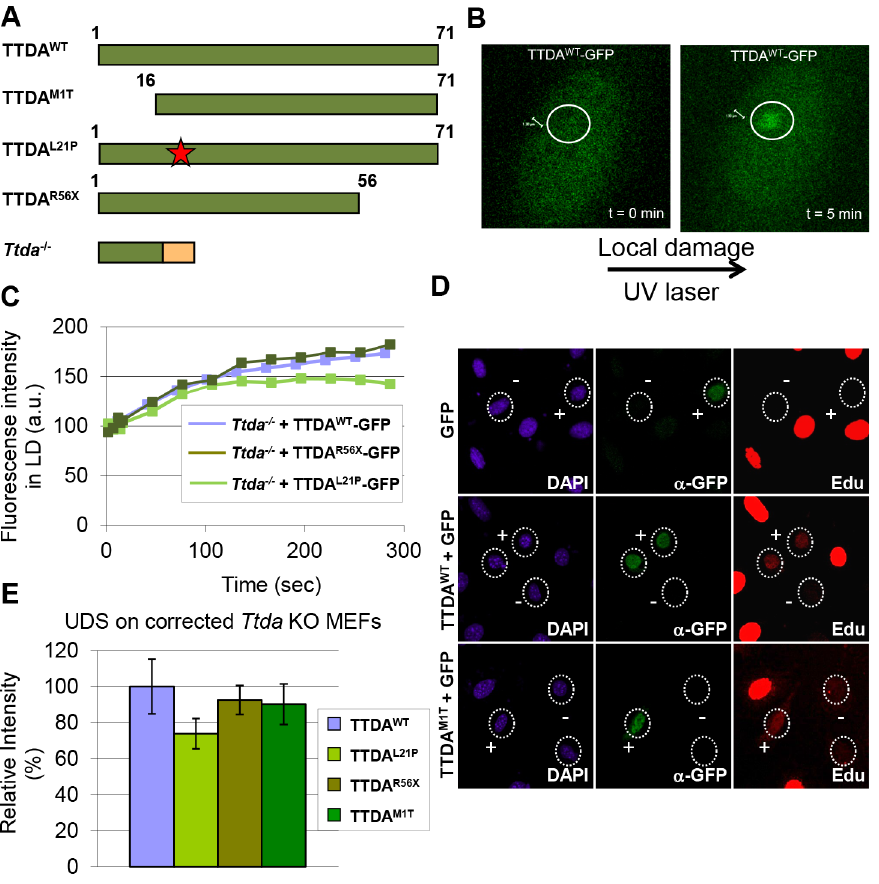
Figure 5. Mutant TTDA protein accumulation at local UV damage. (A) Schematically representation of the predicted TTDA polypeptide length (in amino acids) in human wild-type cells (TTDA WT ), TTD-A patient cells (TTDA M1T , TTDA L21P and TTDA R56X ) and the Ttda knock-out cells ( Ttda 2 / 2 ). The red star represents the mutation found in TTDA L21P and the red part of the Ttda 2 / 2 bar represents intronic encoded non-sense amino acids. (B) Representative confocal images of Ttda 2 / 2 MEFs expressing TTDA WT -GFP before (t=0 min) and after local UV-damage infliction (t=5 min) in a selected area inside the nucleus (dashed circle). (C) Accumulation kinetics of TTDA WT -GFP, TTDA L21P -GFP and TTDA R56X -GFP to local UV-C (laser- induced) DNA damage expressed in Ttda 2 / 2 MEFs. Graphs represents the mean GFP-derived fluorescence intensity at the damaged spot at the indicated time points from approximately 12 cells. (D) Representative confocal microscope images of UV-induced UDS of Ttda 2 / 2 MEFs transiently co- transfected with an empty GFP vector (as a marker for transfected cells) in combination with a vector containing TTDA WT or TTDA M1T . Cells were seeded on cover slips and transfected 2 days before the experiment. Cells were irradiated with 16 J/m 2 and subsequently labeled for 2 hours with EdU. Cells were fixed and stained for EdU incorporation (UDS and S-phase DNA synthesis, red) and GFP using antibodies against GFP (transfected cells, green). The intense red labeled cells are cells in S-phase. (E) The percentage of UDS signal in the nucleus was quantified by measuring the average fluorescence intensity from at least 25 cells positively transfected (containing GFP) and non-S-phase cells with TTDA WT , TTDA M1T , TTDA R56X or TTDA L21P . The error bars indicate the SEM.